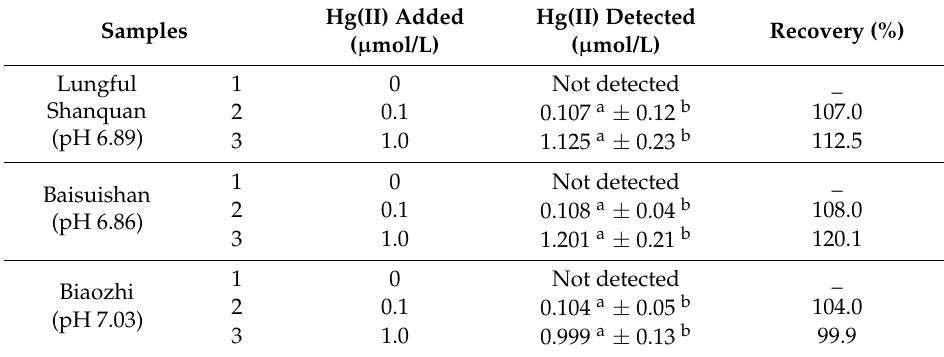
Table 2. Determination of Hg(II) in three mineral water samples by the present method.